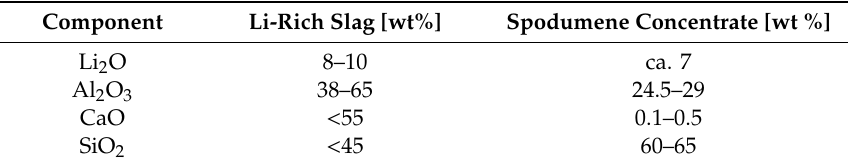
Table 5. Composition of Li-rich slag and spodumene concentrate